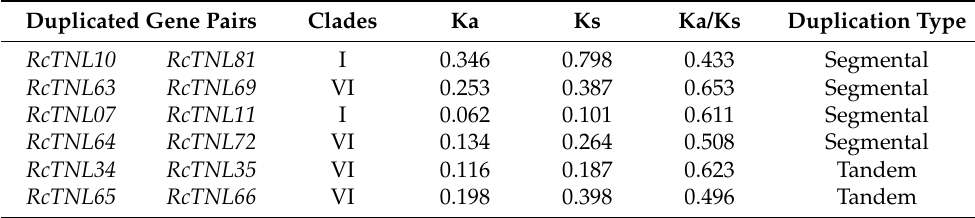
Table 1. Ka/Ks ratio of the duplicated RcTNL gene pairs in collinear blocks.